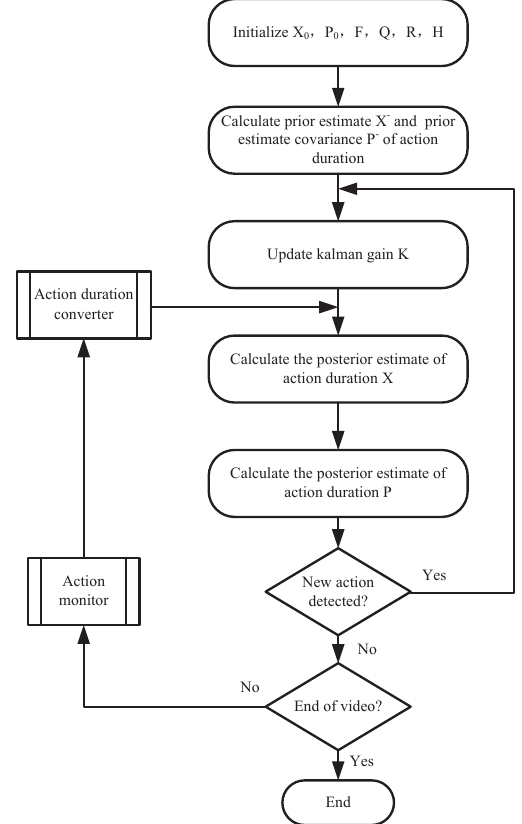
Figure 5. The processing flow of our Kalman